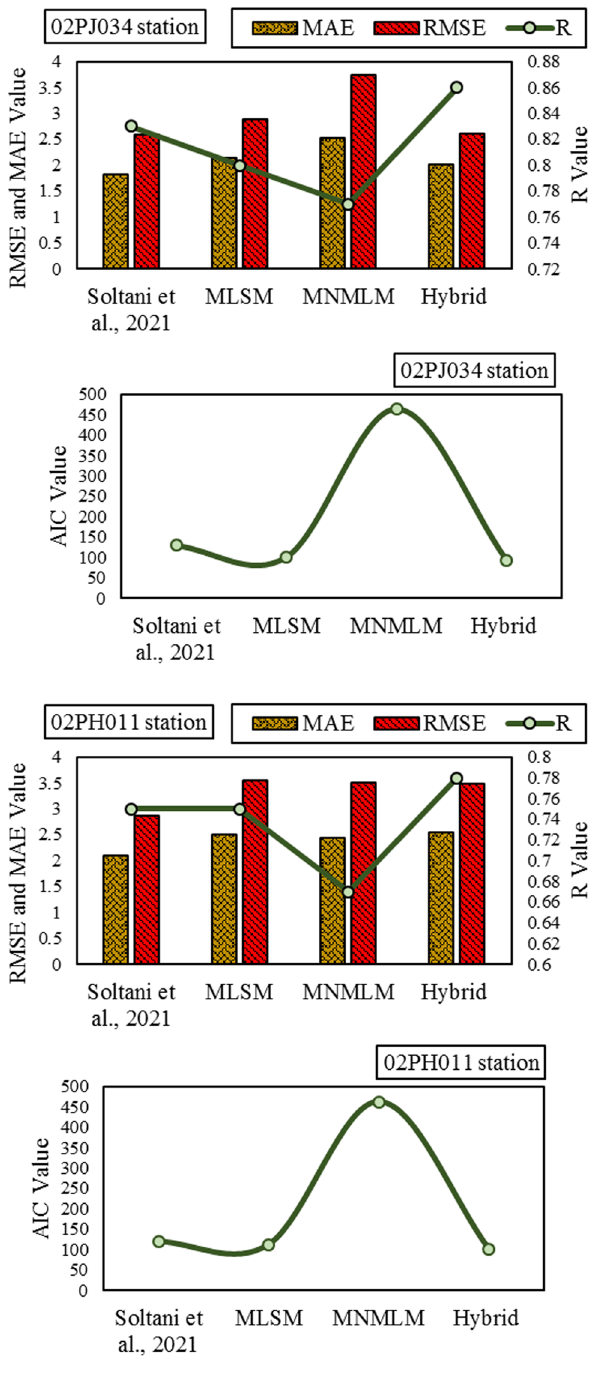
Fig. 8 Comparison of various mathematical criteria including MAE, RMSE, R and AIC for various models and for all stations located of Saint Lawrence River